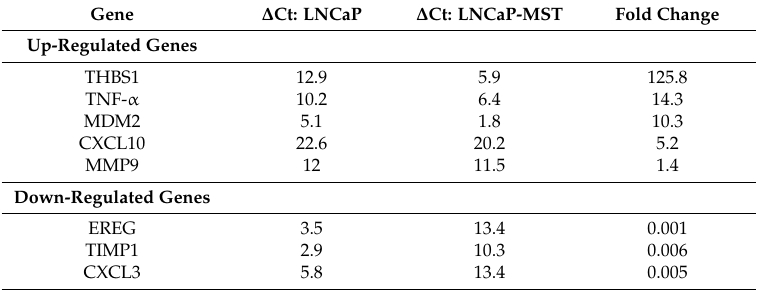
Table 4. Analysis of qRT-PCR for selected genes that are up-regulated and down-regulated in LNCaP-MST cells compared to the LNCaP cells.